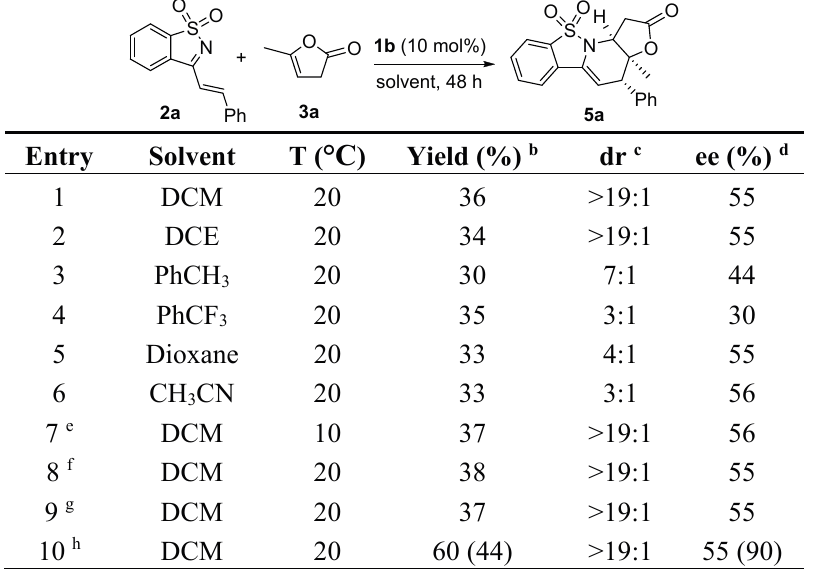
Table 4. Screening studies on the exo -cycloaddition reaction catalyzed by β -ICD 1b a